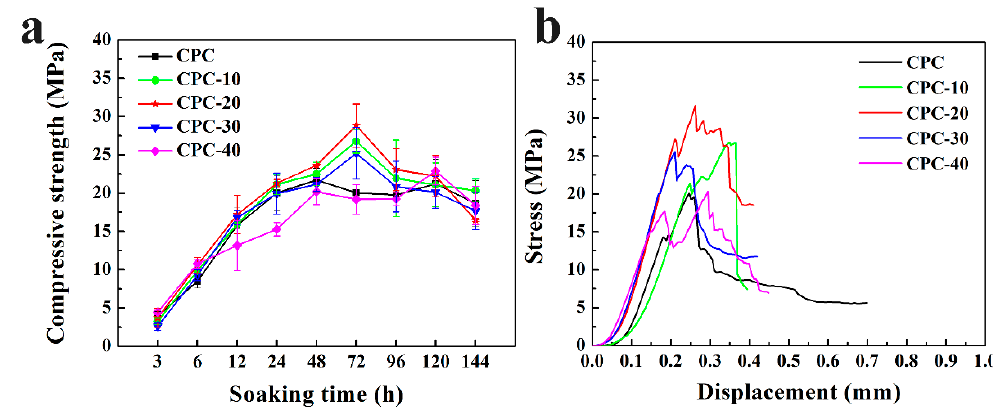
Figure 6. ( a ) The compressive strength of PLGA-PEG-PLGA / CPCs and CPC after immersion for di ff erent times; ( b ) stress vs. crosshead displacement curves of sample CPC and PLGA-PEG-PLGA / CPCs soaked for 72 h (n = 4).